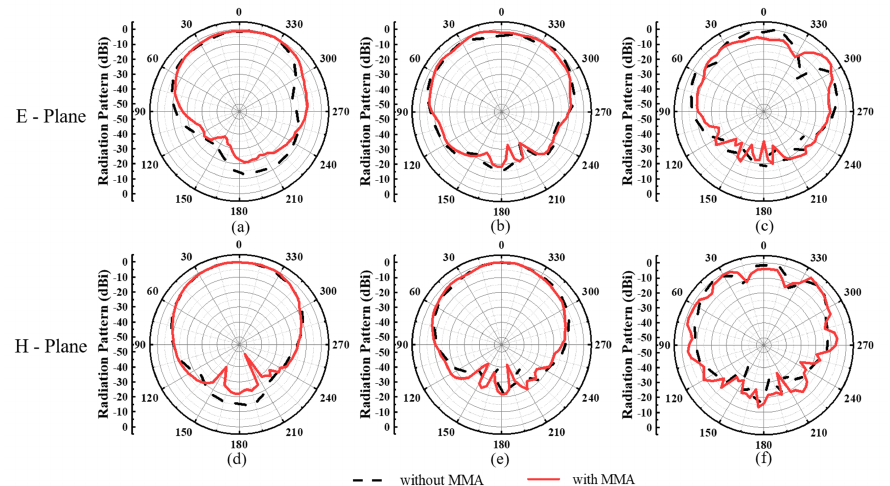
Figure 12. Measured radiation patterns of the normalized amplitude of the transceiver antenna with and without the MMA: ( a – c ) E-plane and ( d – f ) H-plane at 1.0 GHz, 2.0 GHz, 3.0 GHz,